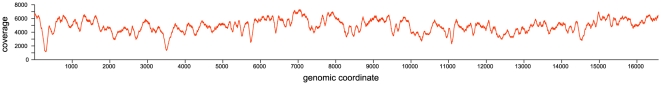
Coverage of each position across the whole mitochondrial genome, considering all the samples together.